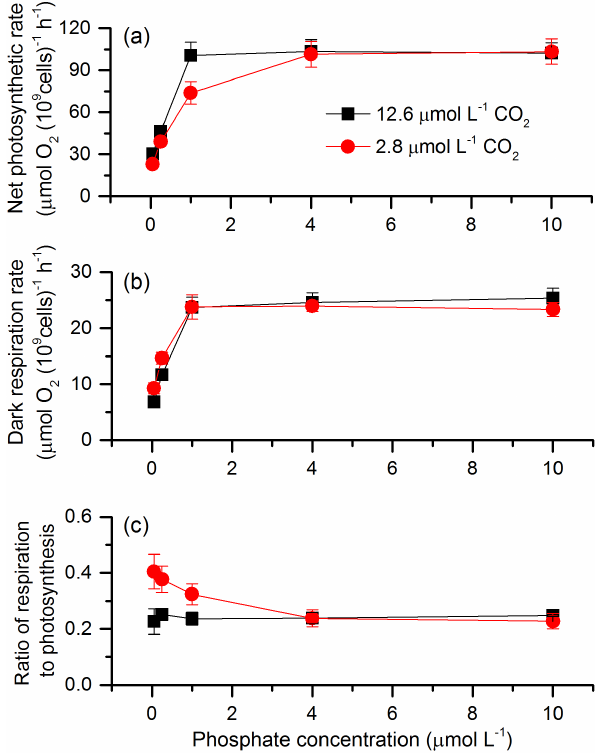
Figure 1. Net photosynthetic rate (a) , dark respiration rate (b) , and ratio of respiration rate to net photosynthetic rate (c) in S. costa- tum grown at various phosphate concentrations after 12.6 and 2.8µmol CO 2 treatments. The error bars indicate the standard devi- ations ( n =